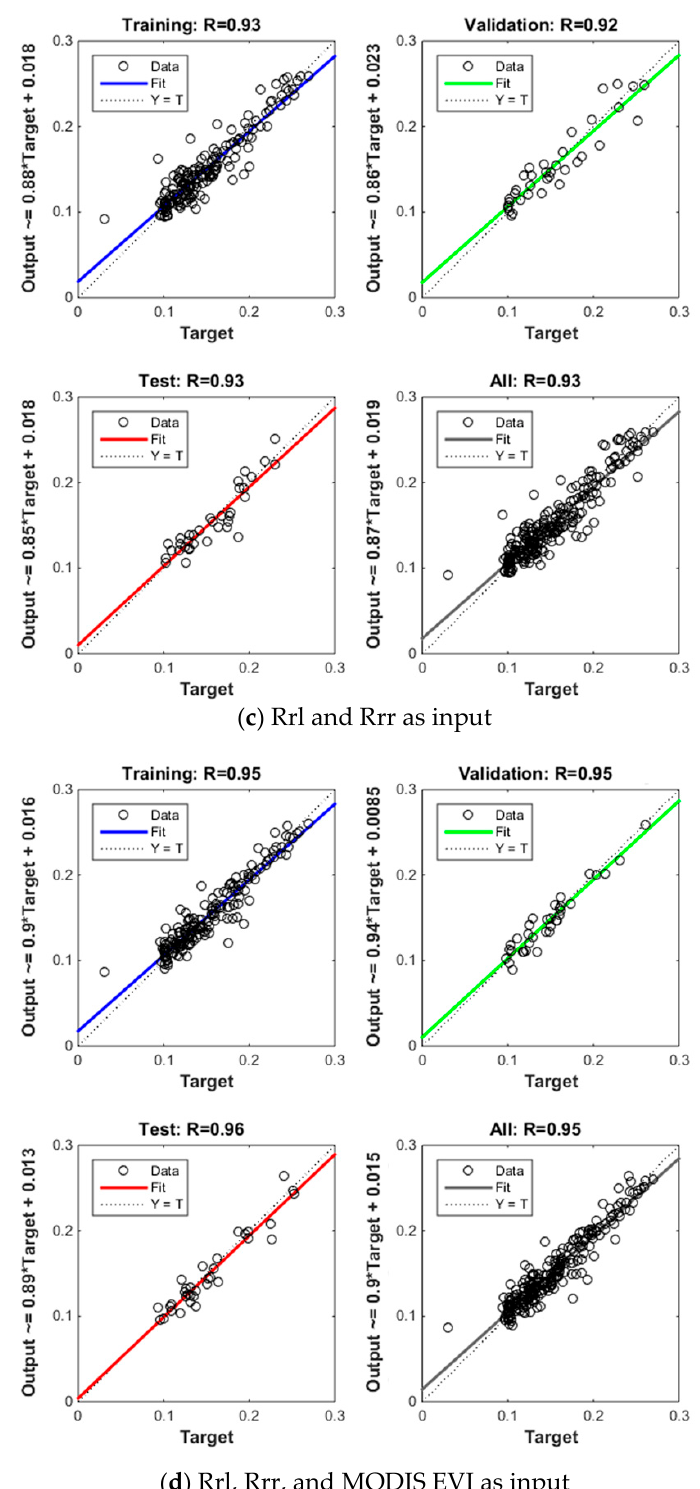
Figure 9. Regression of GNSS-R Neural Net Fitting.